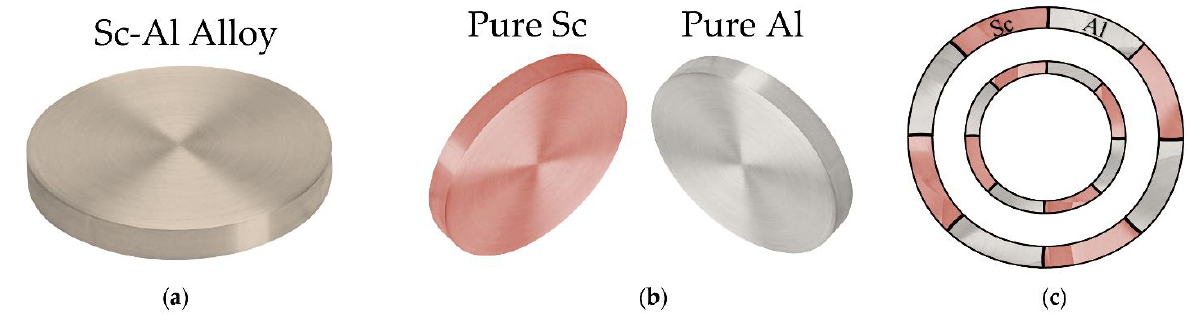
Figure 2. Schematic representation of different target designs with ( a ) Sc-Al Alloy target, ( b ) pure Sc and pure Al targets for dual co-sputtering, and ( c ) ring-shaped segmented target with alternating Sc and Al tiles.